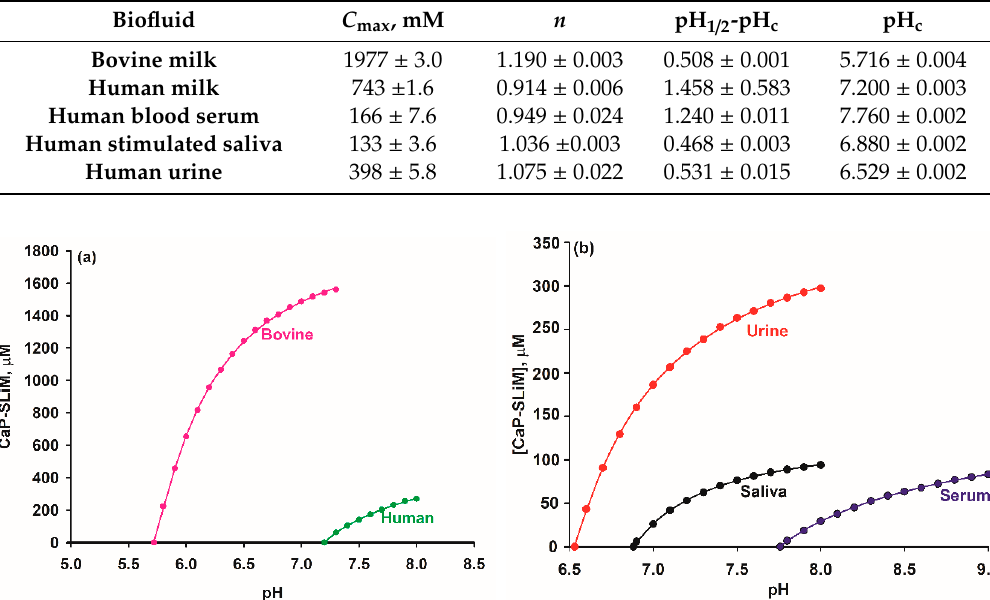
Figure 11. Stability diagrams for typical biofluids ( a ) bovine and human milk and ( b ) human urine, saliva, and blood serum. Reprinted with permission from Holt et al. [13] © 2013The Authors. Published by Elsevier Inc. All rights reserved.